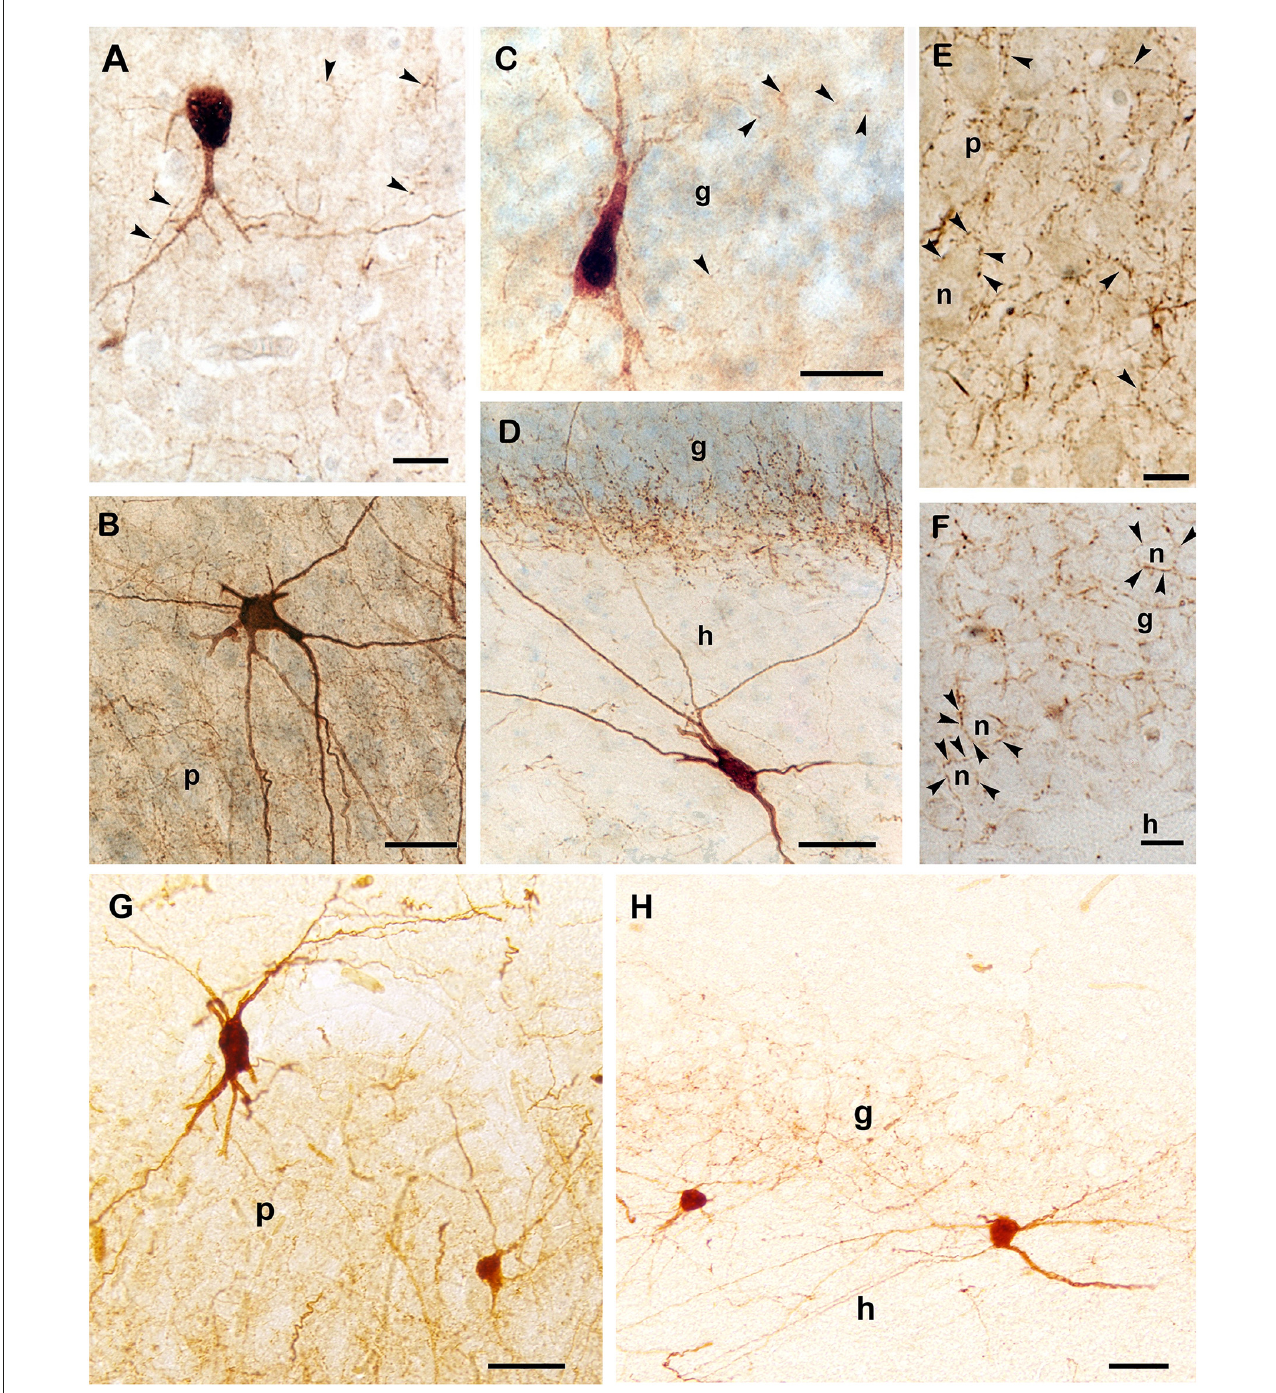
FIGURE4 PV-immunoreactive interneurons and axons in the hippocampal formation of a 1-month-old (A) , a 3-month-old (C) , and in an 11-year-old (B,D–F) child. (A) PV-positive cell with immature morphology and sparse dendritic branches in a 1-month-old infant. (B) Large, multipolar PV-positive cell in the pyramidal layer of Ammon’s horn of an 11-year-old child. The PV-positive axonal network is confined to the pyramidal cell layer. (C) Soma and main dendrites of a PV-immunoreactive cell in the granule cell layer of the dentate gyrus in a 3-month-old infant. (D) A large PV-immunoreactive hilar (h) neuron with long dendrites that cross the granule cell layer of an 11-year-old child. Inside the granule cell layer, the dense PV-immunoreactive axonal networkappearstobedenseratthehilarborder.Thedensityofaxonalbranchesislowinthehilusthatcorrespondswithalowercellulardensityinthehilus than in the granule cell layer. (E) High magnification photomicrograph of the PV-positive axonal network in the pyramidal layer. (F) Large magnification photomicrograph of PV-immunoreactive axon terminals in the granule cell layer of an 11-year-old child. Arrowheads point to PV-immunoreactive axonal swellings (terminal-like boutons). The axons (arrowheads) display large numbers of boutons that appear to surround somata of pyramidal (E) and granule cells (F) . (G) PV-immunoreactive cells and axonal plexus in the CA1 pyramidal layer of an adult. (H) PV-immunoreactive neurons in the subgranular layer of the dentate gyrus in an adult. Boutons of PV-immunoreactive axons are visible in the granule cell layer of the dentate gyrus. Scale bars = 10 µ m in (F) , 20 µ m in (A) and (E) , 25 µ m in (C) , and 50 µ m in (B,D,G) , and (H) . Abbreviations: g, granule cell layer; h, hilus of the dentate gyrus; n, neuronal soma; p, pyramidal layer of Ammon’s